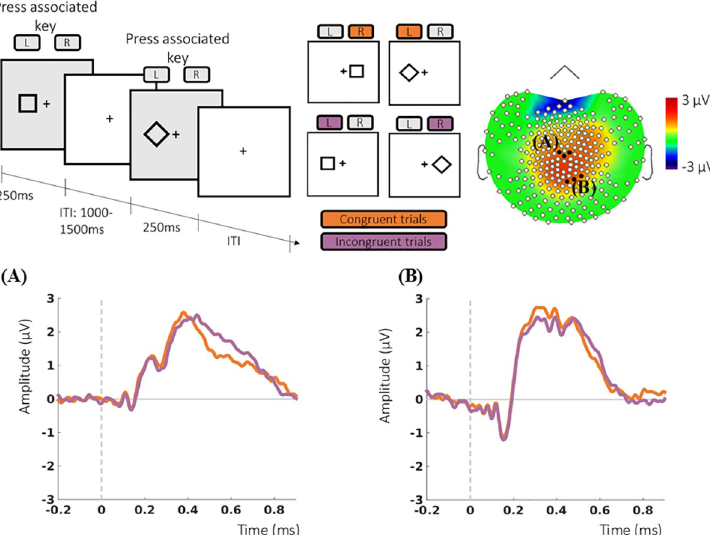
Fig 3. Simon task and evoked potentials. Upper panel shows example trials of the Simon task and the grand average topographic maps for the P300 with the two clusters of electrodes used for analysis highlighted (A and B). During the Simon task (upper right panel) participants responded to one of two 2.5 x 2.5 cm geometrical shapes (square or diamond) mapped to either a left or a right button press (counterbalanced across participants). Participants were instructed to press the button associated with the stimulus, regardless of where it appeared. There were 380 trials, 190 congruent (side of presentation and required response the same) and 190 incongruent (required response opposite to the side of presentation), presented in random order. Following the motor response, there was an inter-trial interval lasting 1 to 1.5 seconds (ITI). (A) Grand average over the electrode cluster surrounding Cz and (B) over a cluster chosen following a data-driven